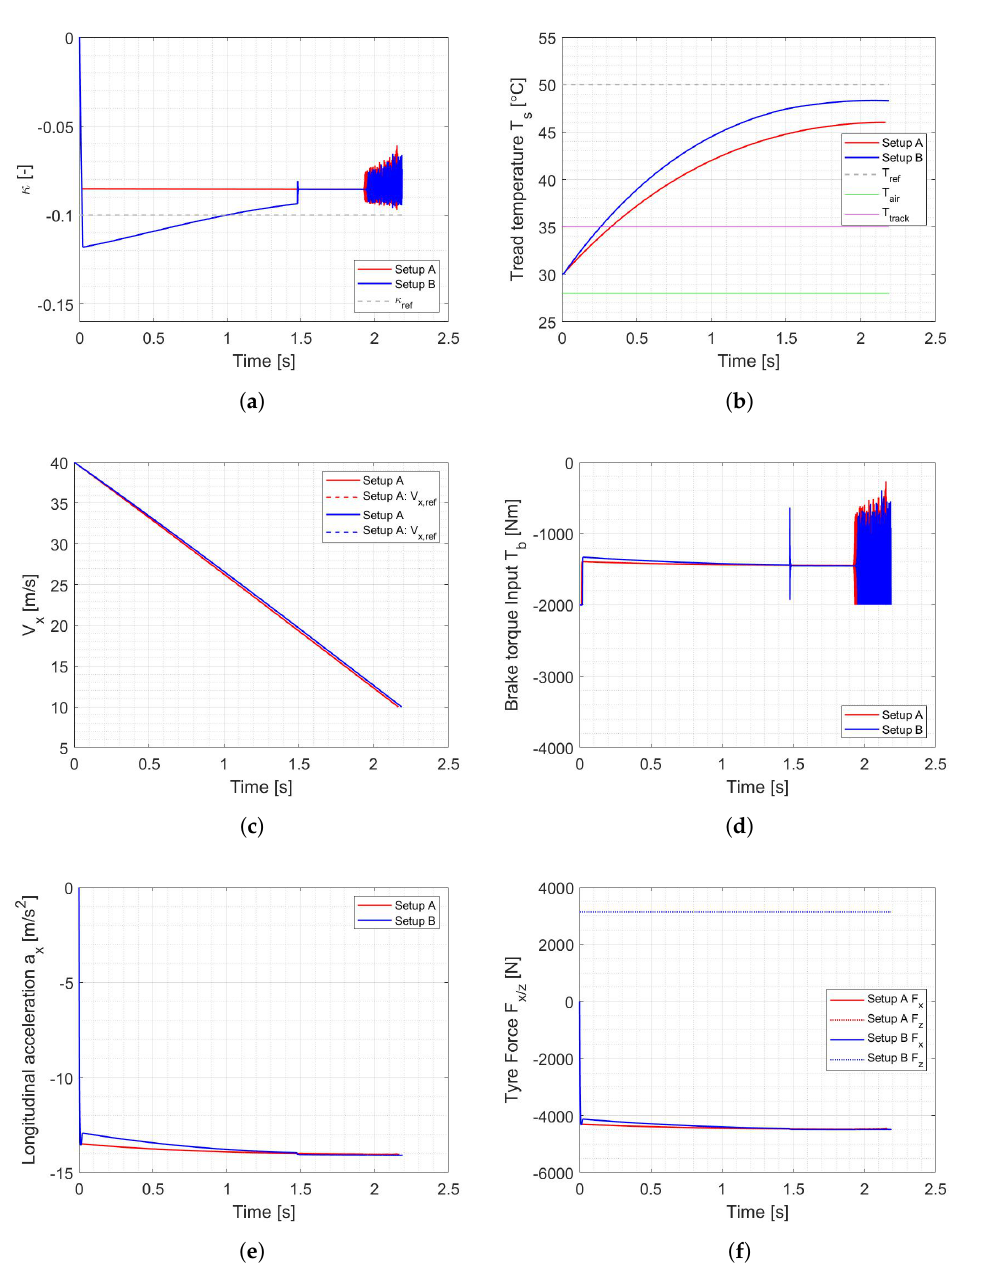
Figure 17. Time histories of variables and control inputs for all the setups (A and B) of quarter-car SDRE ABS controller with T a = 28 ◦ C and T t = 35 ◦ C, starting at 40 m/s. ( a ) Longitudinal slip κ . ( b ) Tread temperatures T s . ( c ) Vehicle longitudinal velocity V x . ( d ) Brake torque control input T b . ( e ) Vehicle longitudinal acceleration. ( f ) Longitudinal force F x and vertical load F z